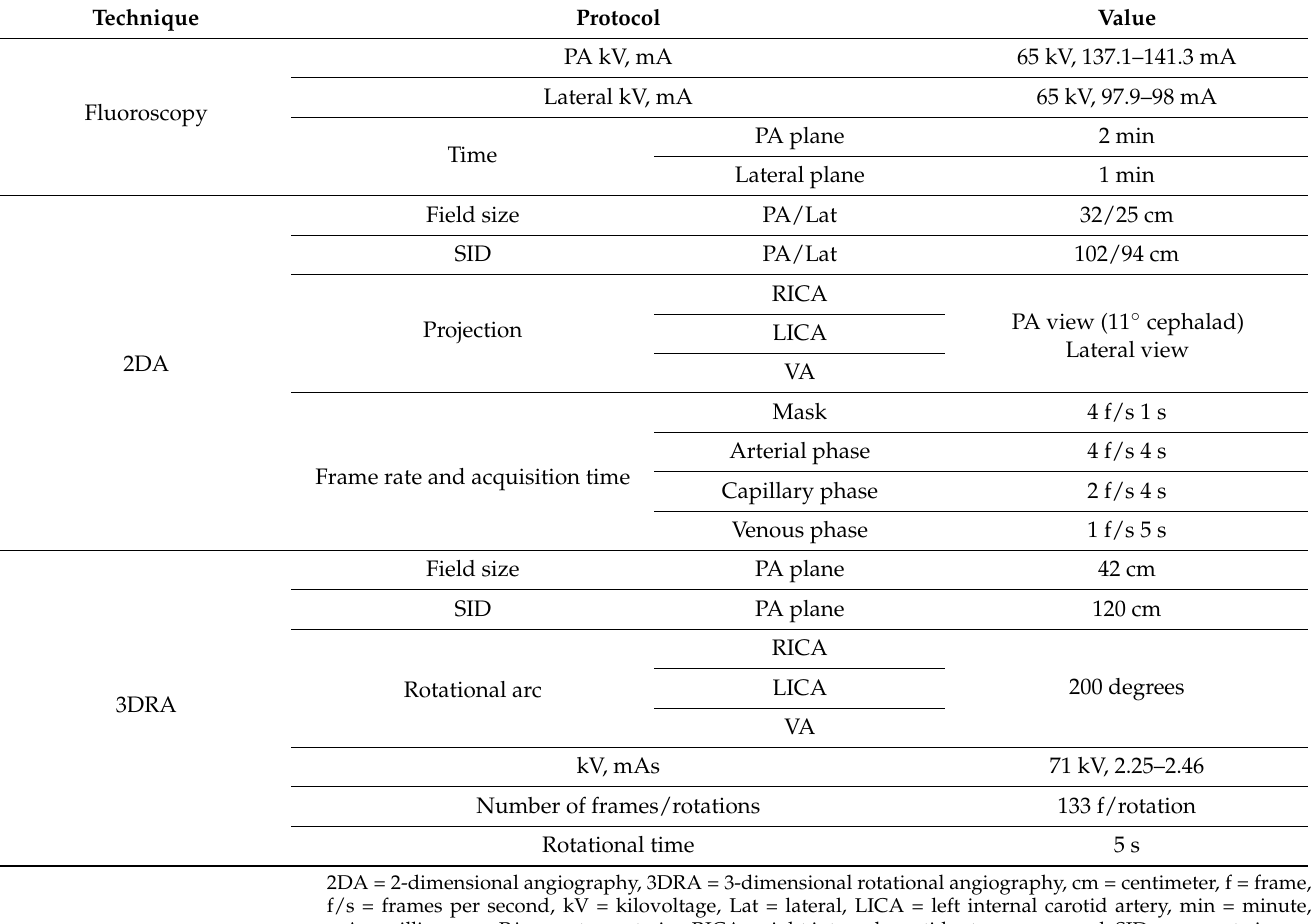
Table 1. Cerebral angiographic protocol and exposure parameters of the conventional and high kV techniques in the phantom